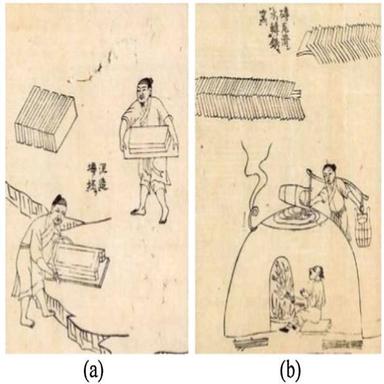
Illustration of production process of GCBs in Tiangong Kaiwu .